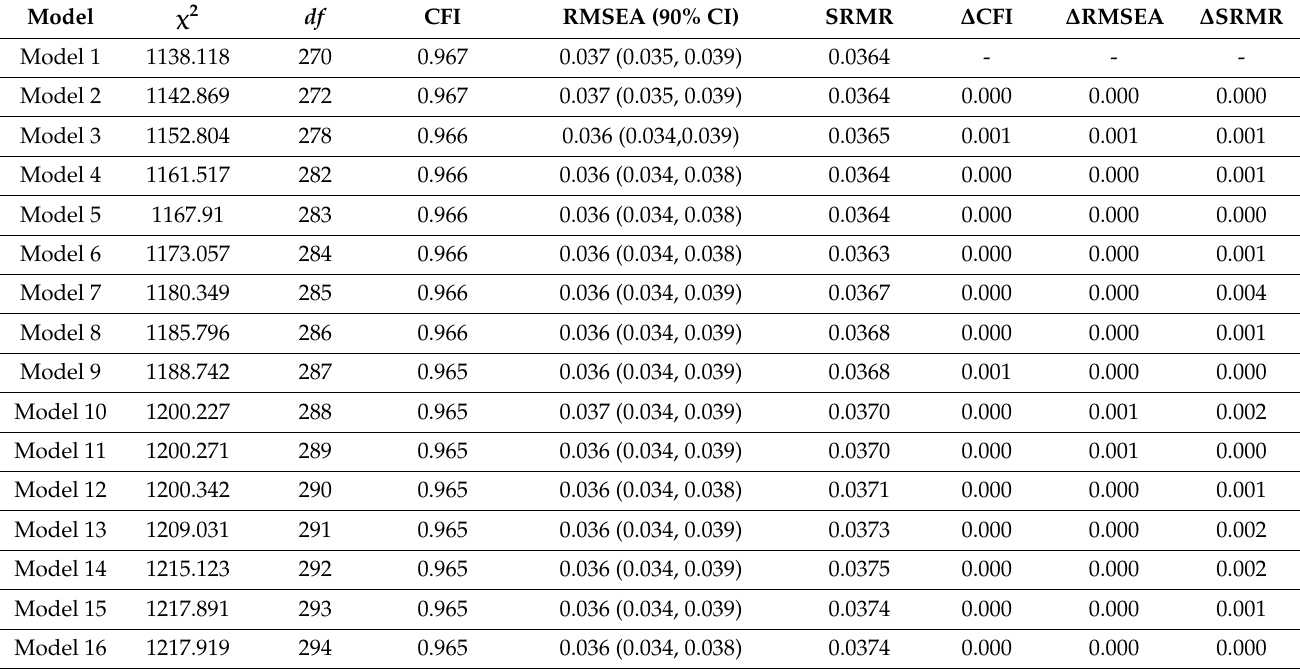
Table 3. Fit indices for the nested model